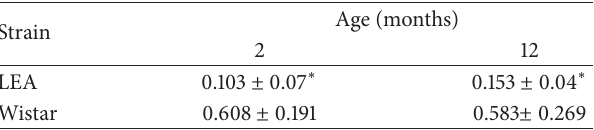
𝑛 = 32 for males; 𝑛 = 35 for females. Table 2: Insulinogenic index ( Δ I.I.) for primary insulin secretion in male LEA rat.